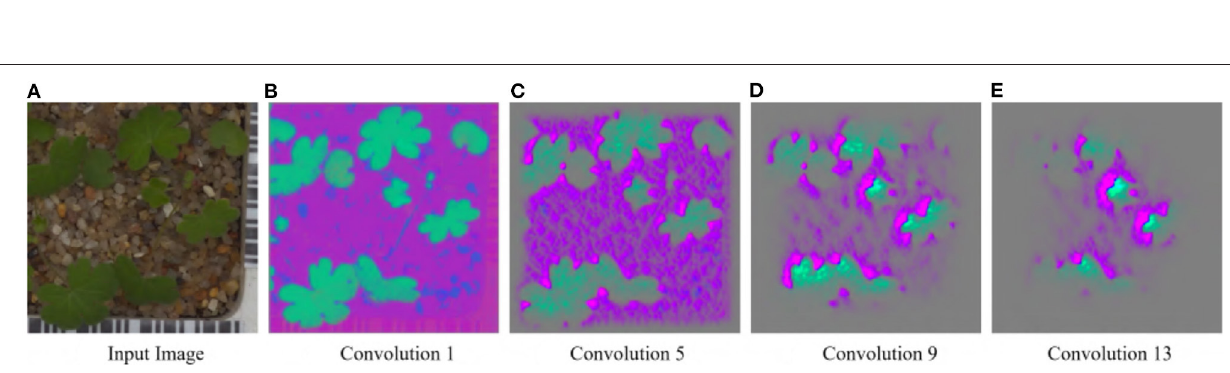
Frontiers in Artificial Intelligence |